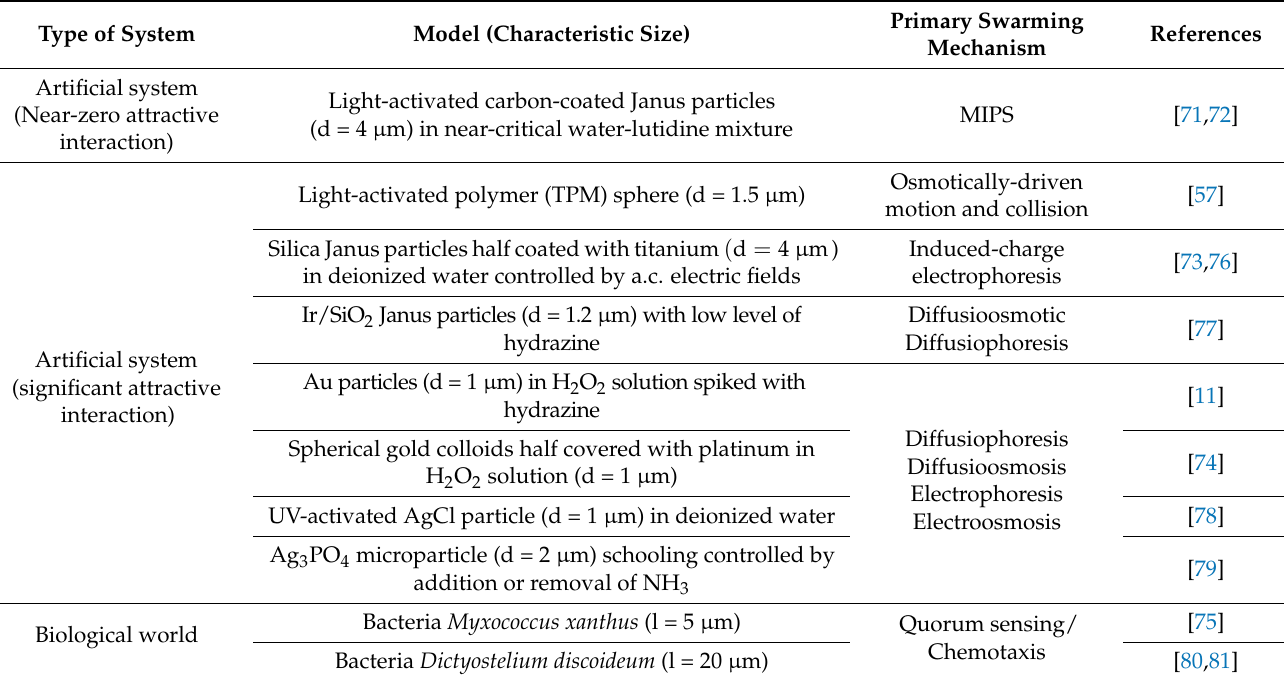
Table 2. Experiments showing clustering phenomena; d = diameter, l =